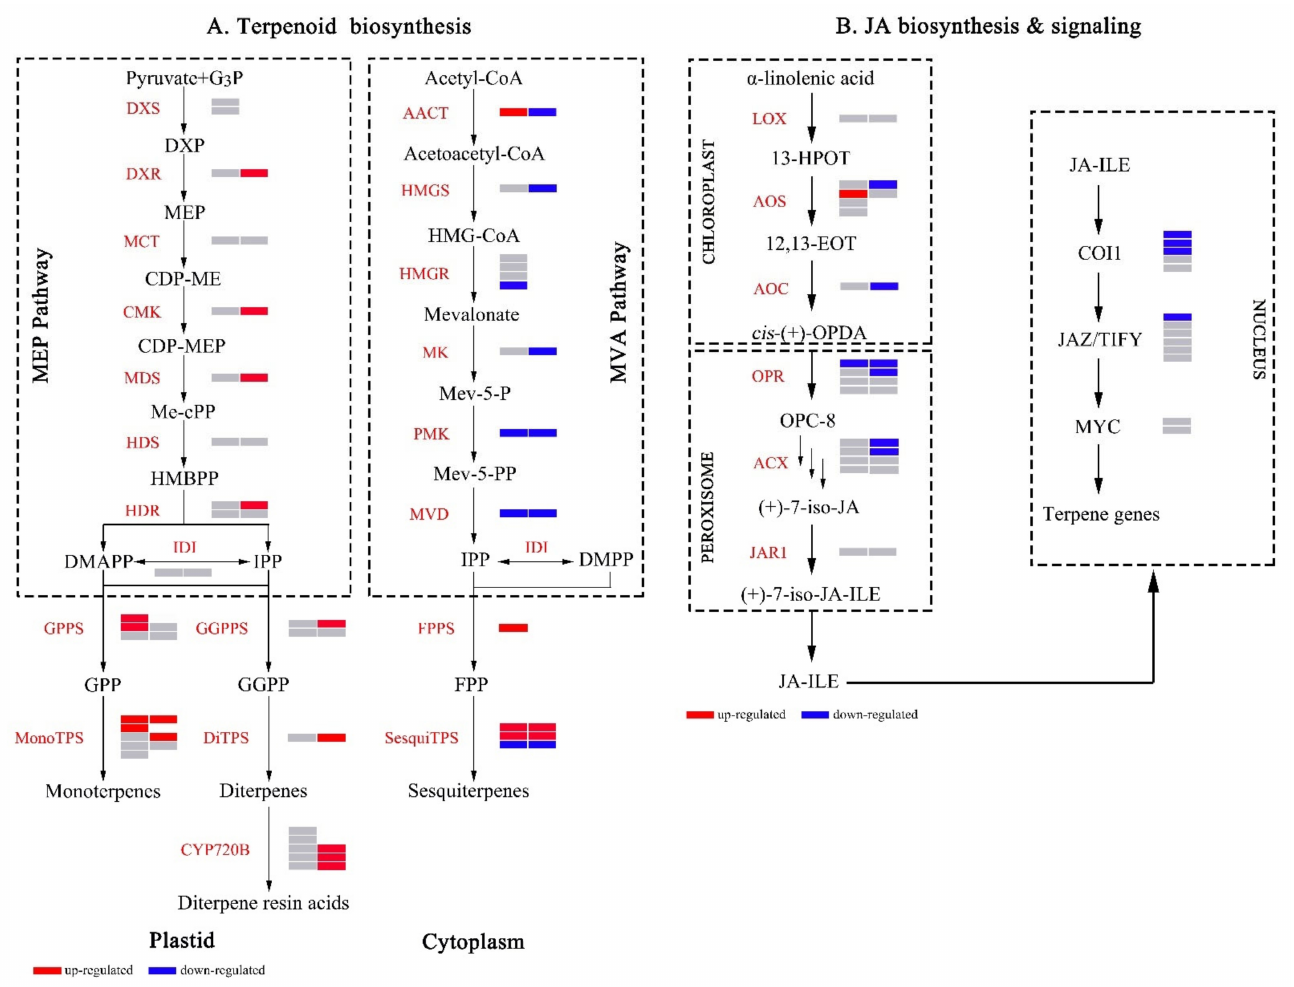
Figure 8. Heatmap of DEGs and DEPs related to terpenoid biosynthesis ( A ), JA biosynthesis & sig- naling ( B ). Up- and down-regulated DEGs/DEPs were indicated by red and blue colors, respectively. Nonsignificant genes/proteins were indicated by a gray color. The cells (from left to right) in the heatmap represent the expression change of gene and protein, respectively. The deletion of the cells on the right represents that the protein corresponding to the gene was not detected in the iTRAQ